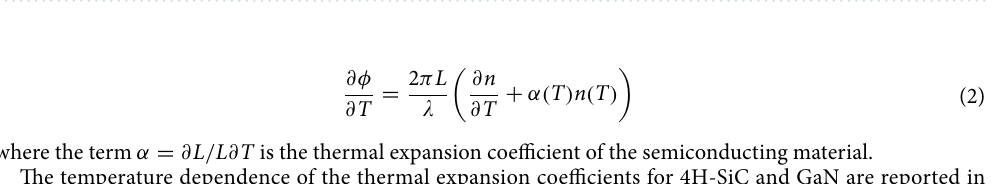
Figure 2. Example of a transmitted signal amplitude plot as a function of temperature for the 4H-SiC